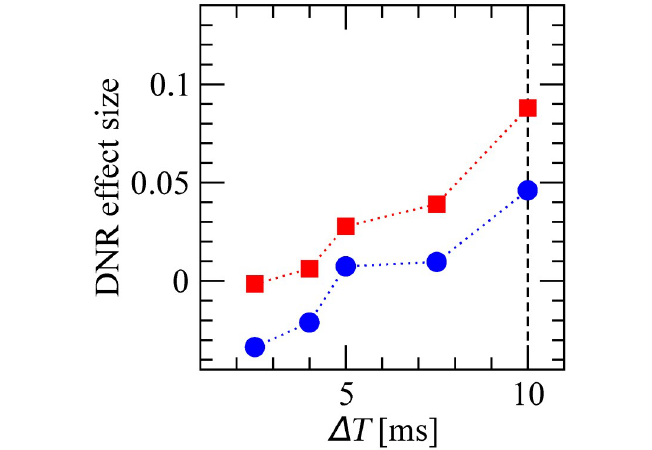
Fig 11. Effect size measured by the DNR is robust for Δ T ⪆ 5 ms. Effect size measured by the DNR as a function of the delay difference Δ T measured upon regular (blue circles) and irregular (red squares) stimulation.